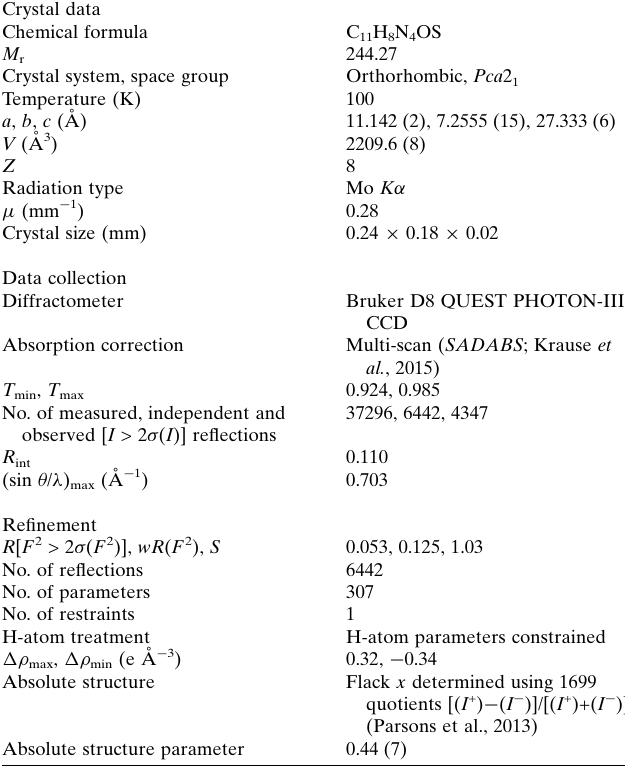
Table 4 Experimental details. Crystal data Chemical